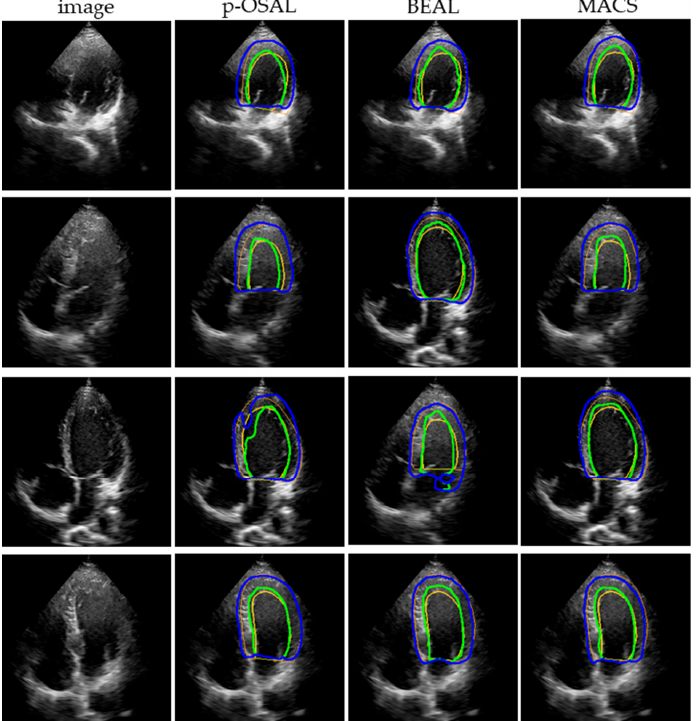
Figure 8. Representative visual segmentation results of adversarial learning methods. Green and blue contours indicate boundaries of the LV endo and LV epi , respectively. Yellow and orange colors denote the ground truth.